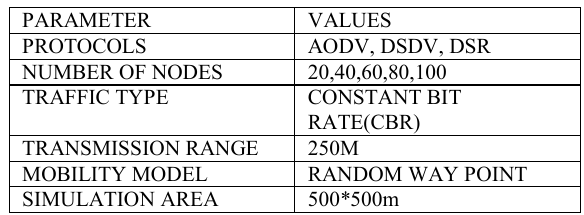
Table 3:- Packet Loss